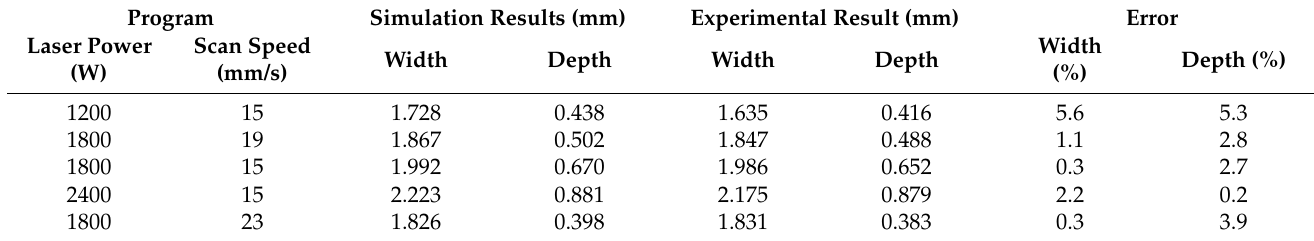
Table 2. Comparison and error of molten pool size.